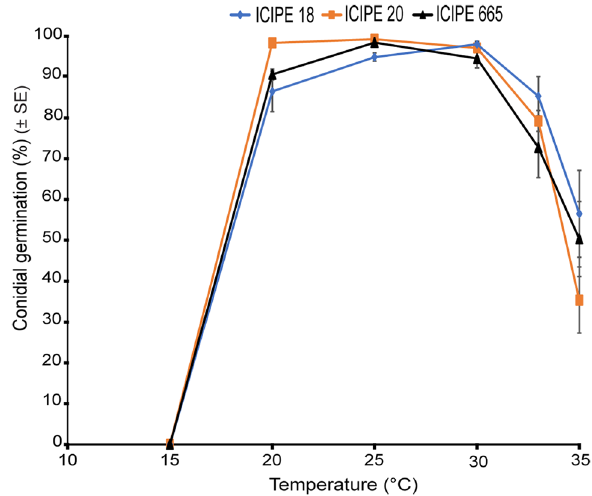
Figure 1. Effect of temperature on conidial germination of the three Metarhizium anisopliae fungal isolates ICIPE 18, 20 and 665. Error bars indicate the standard error of the mean at 95% CI (n = 72; N = 4; Tukey’s HSD test).